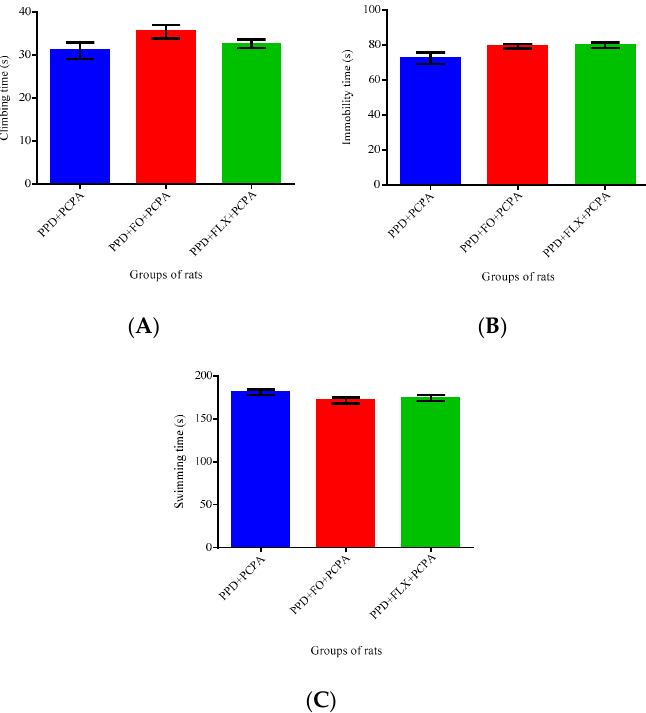
Figure 4. Effect of PCPA on FO and FLX on Forced swimming test in PPD-like rats. ( A ), climbing time. ( B ), Immobility time and ( C ), Swimming time. One-way ANOVA revealed no statistically significant di ff erences among the rat groups. Data presented as mean ± SEM, n = 6. (PPD—postpartum depression-like, FO—fish oil, FLX—fluoxetine,